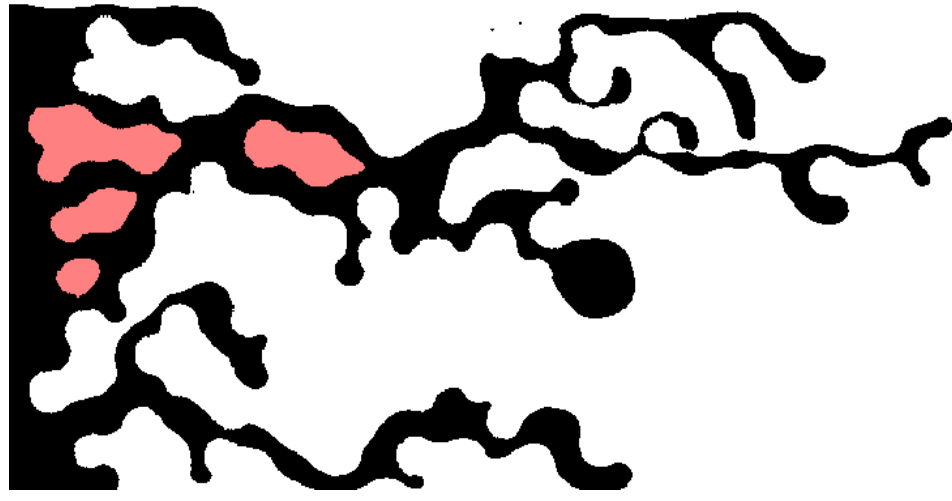
Figure 4. The entrapment effect in the micromodel. The flow direction is from left to right. White represents the porous medium, black is the displacing fluid, and red is the entrapped oil.